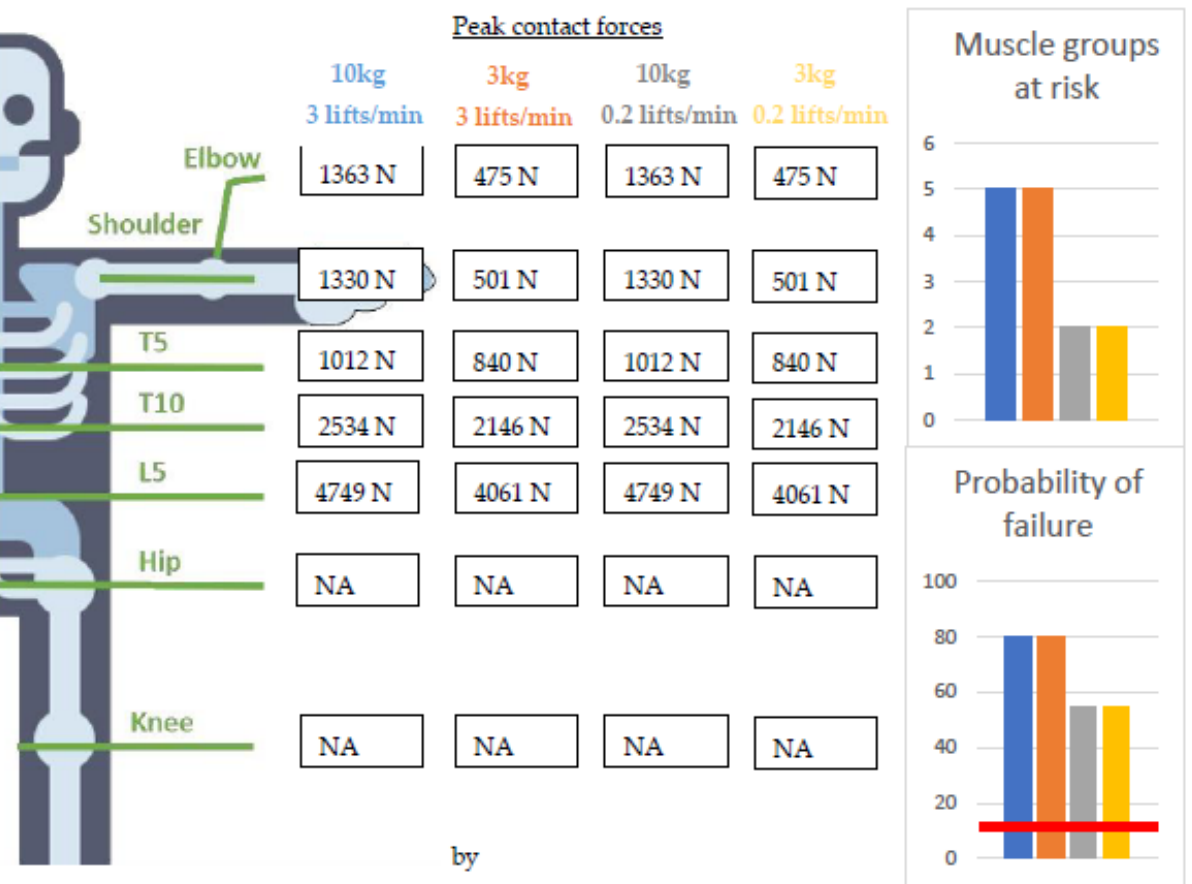
Figure 3. Peak joint contact forces in the different joints calculated with the musculoskeletal-modeling workflow and compared to the different tissue-specific injury thresholds implemented in the MATE for the different working conditions. Values above the red line are high risk. Ground reaction forces were not considered, and a top-down approach was used. As a result, the hip and knee joints could not be analyzed (NA).